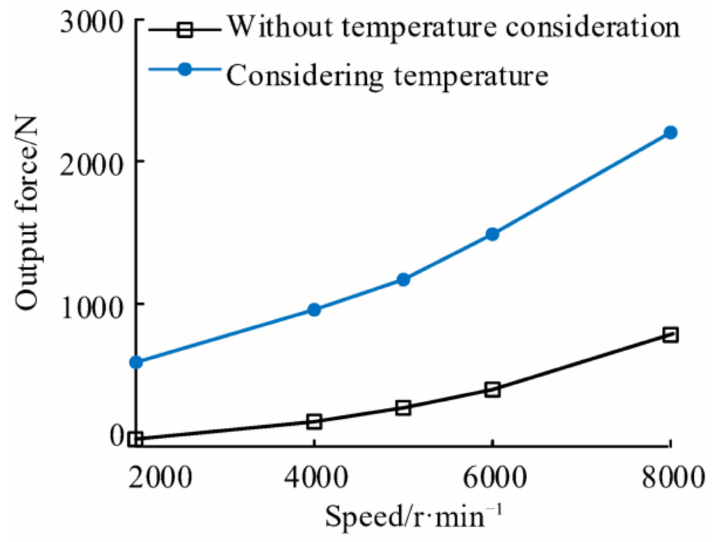
Figure 13. Output forces of NPR spacer at different